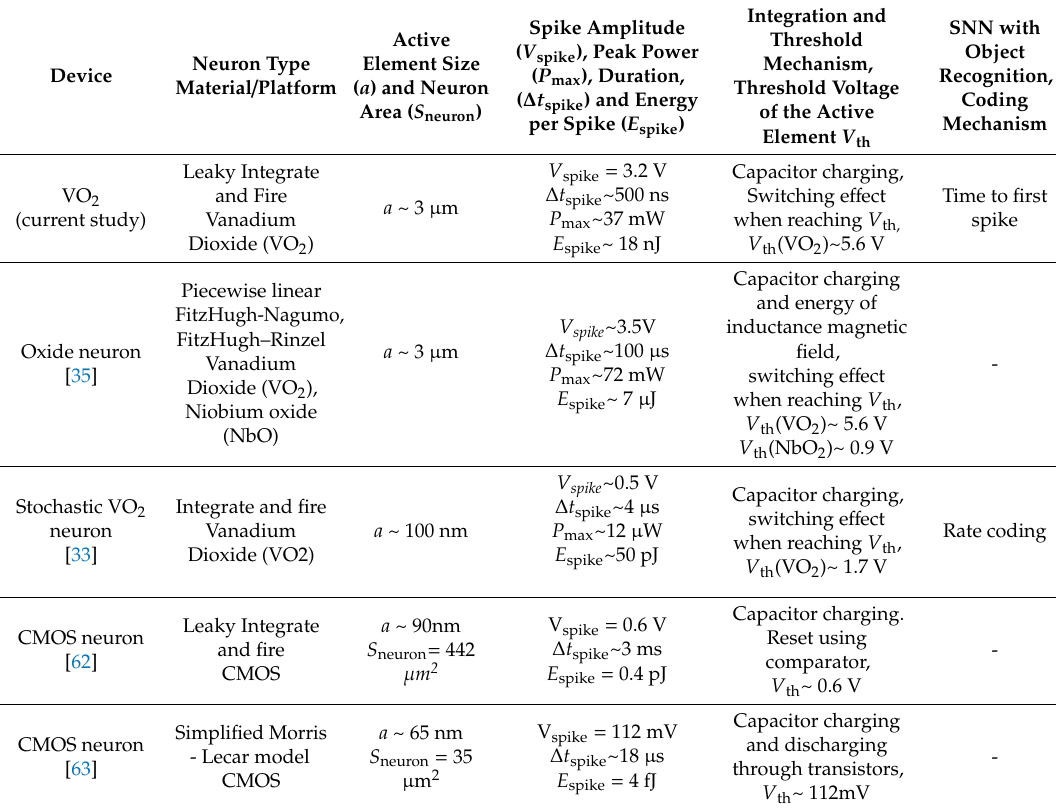
Table 2. Comparison of neurons with other proposed neuron